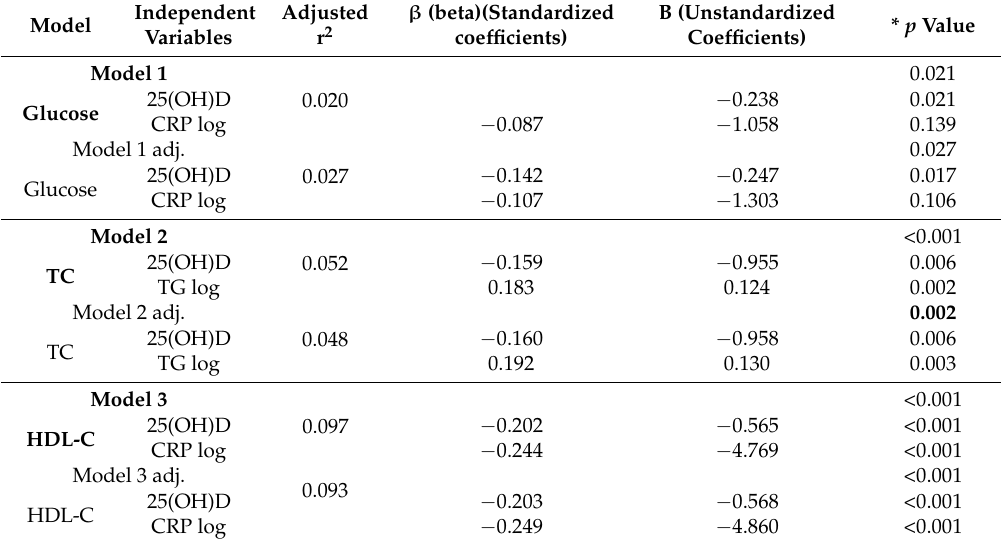
Table 4. Impact of 25(OH)D concentration on glucose and